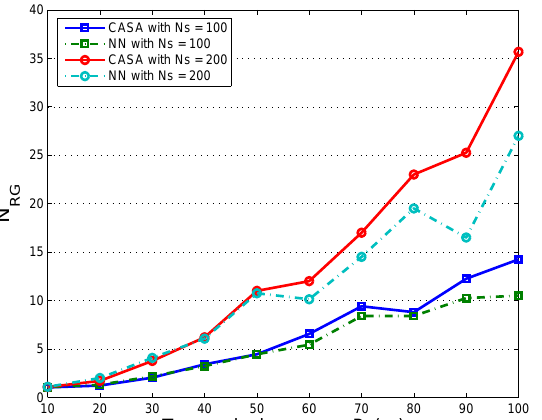
applying the pro- RG